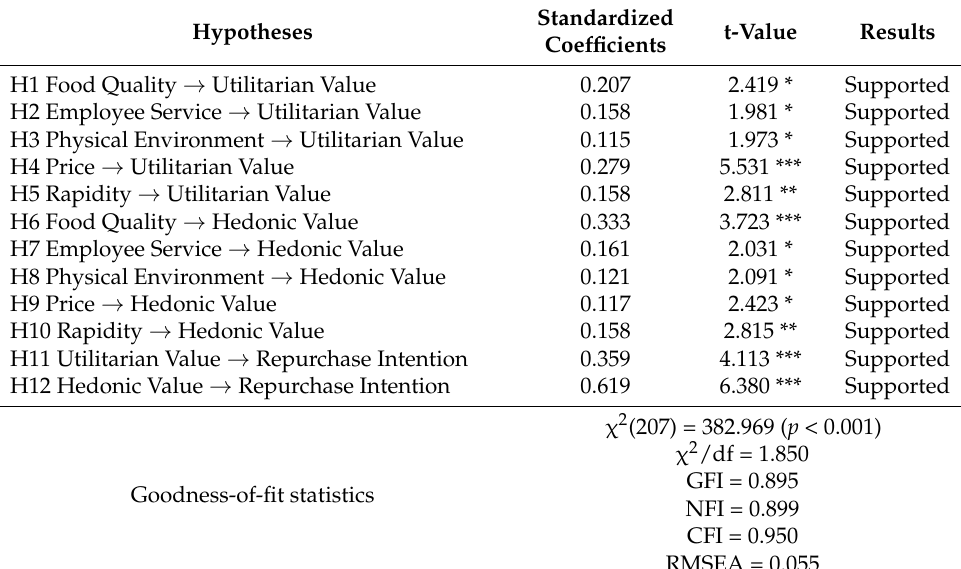
Table 5. Model fit indices of food safety risk groups.